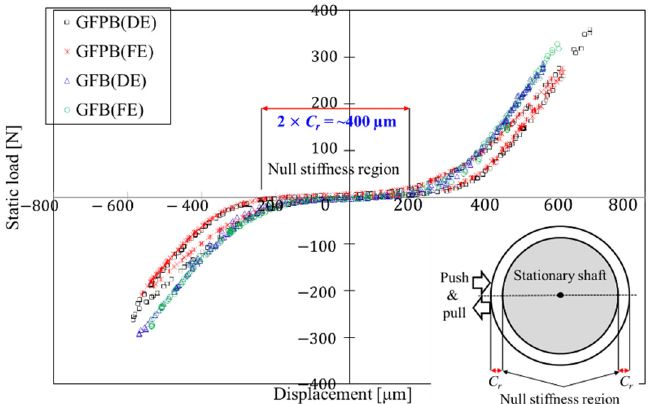
Figure 4. Measured static load versus displacement during consecutive static loading–unloading process for GFB and GFPB.